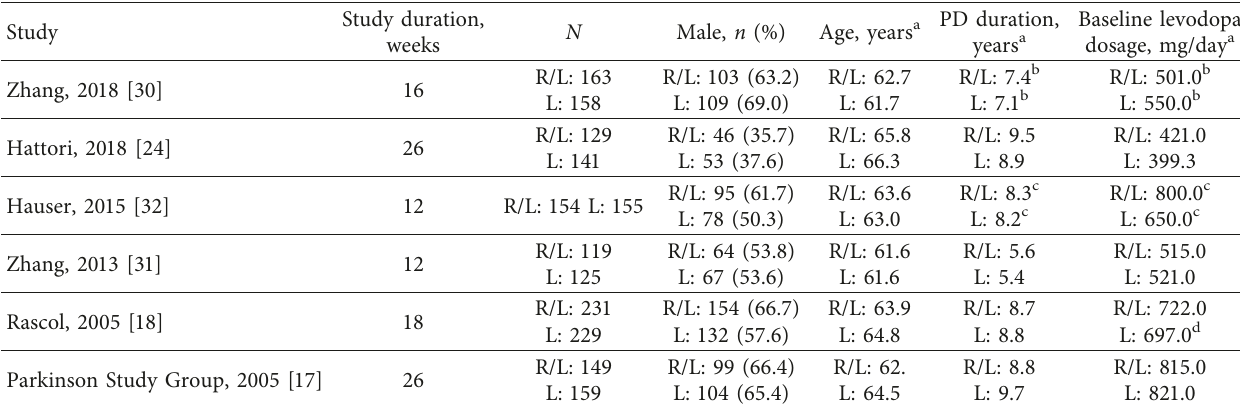
Figure 1: PRISMA flow diagram. PRISMA, Preferred Reporting Items for Systematic Reviews and Meta-Analyses; RCT, randomized controlled trial. Table 1: Characteristics of studies